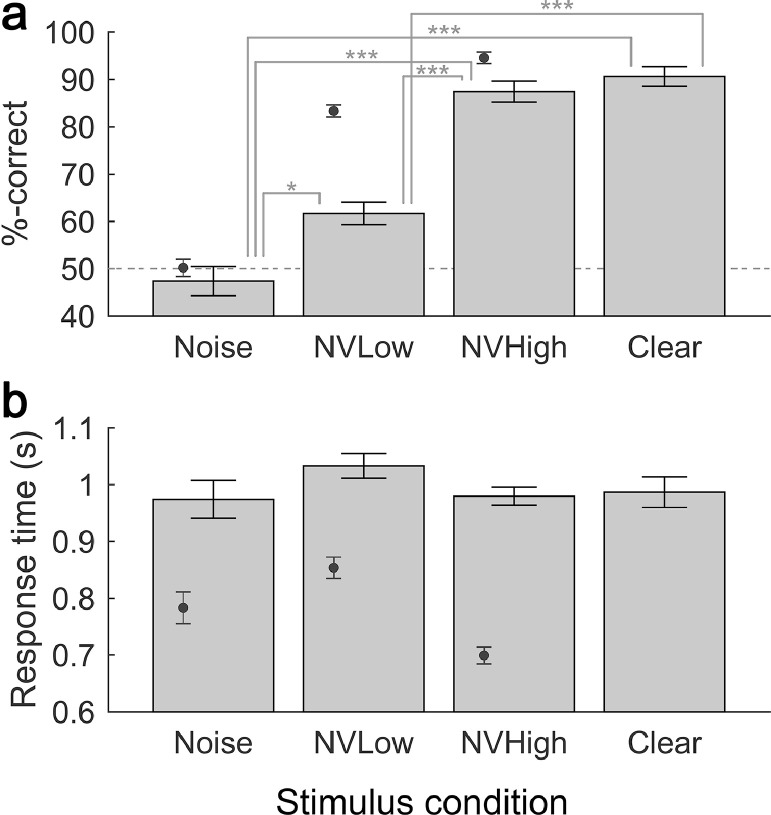
Behavioural results collected concurrently with fNIRS imaging. Mean accuracy (a) and response time (b) is shown for each of the four stimulation conditions. The bars show results for children in the present study, while the inset markers show comparative data for normally hearing adults acquired in our previous study (Lawrence et al., 2018). Error bars show ±1 standard error of the mean (corrected for repeated measures). The dashed horizontal line in (a) represents chance performance. Asterisks indicate significant pairwise differences in post-hoc tests following a significant RM-ANOVA omnibus test result (* p < .05, ** p < .01, *** p < .001, Bonferroni-corrected).